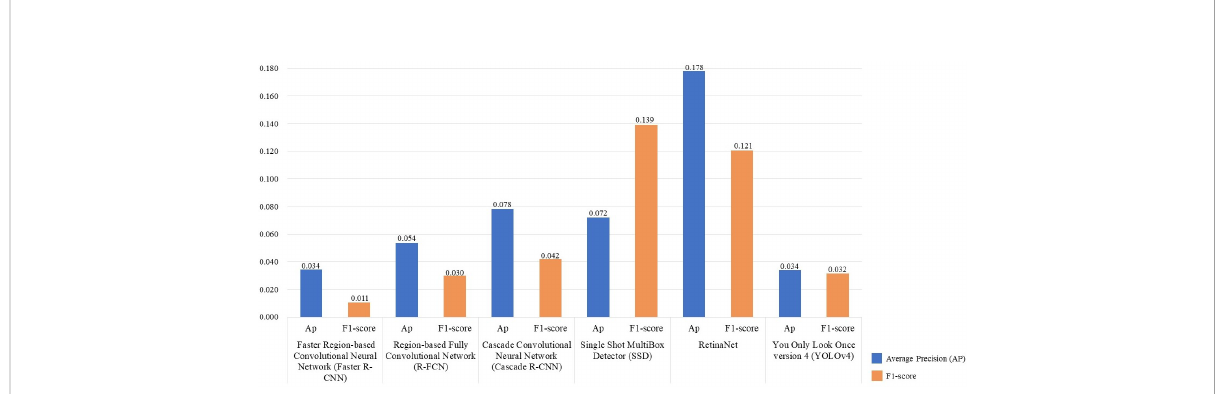
FIGURE 5 The standard deviation of Average Precision (AP) and F1-score in three datasets for six Deep-Learning (DL) models: Faster Region-based Convolutional Neural Network (Faster R-CNN), Region-based Fully Convolutional Network (R-FCN), Cascade Convolutional Neural Network (Cascade R-CNN), Single Shot MultiBox Detector (SSD), You Only Look Once version 4 (YOLOv4). The standard deviation measures the dispersion of accuracy among three